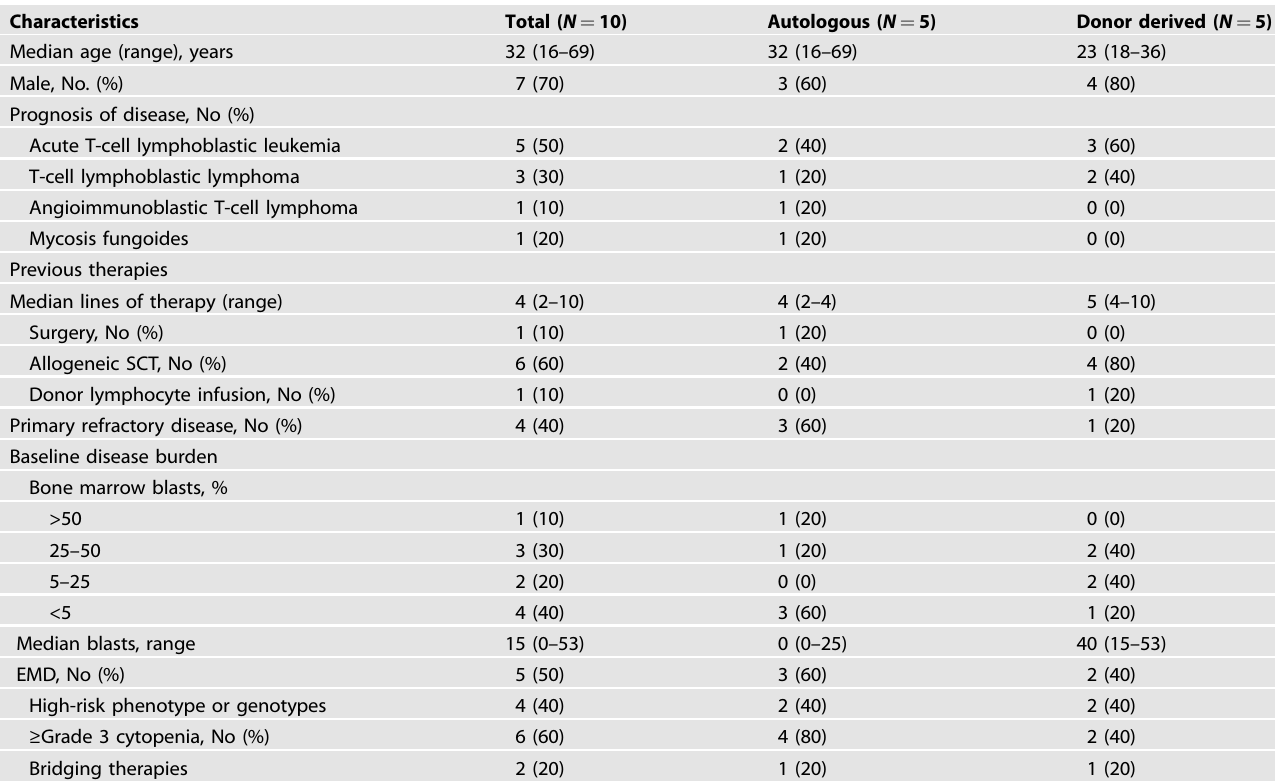
Table 1. Baseline patient